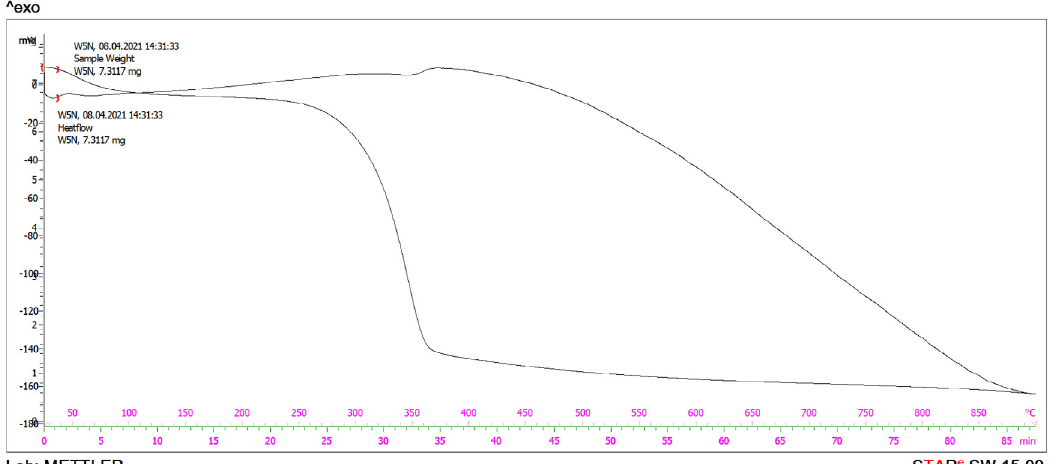
Fig. 8. Thermogravimetric analysis of Nanocellulose